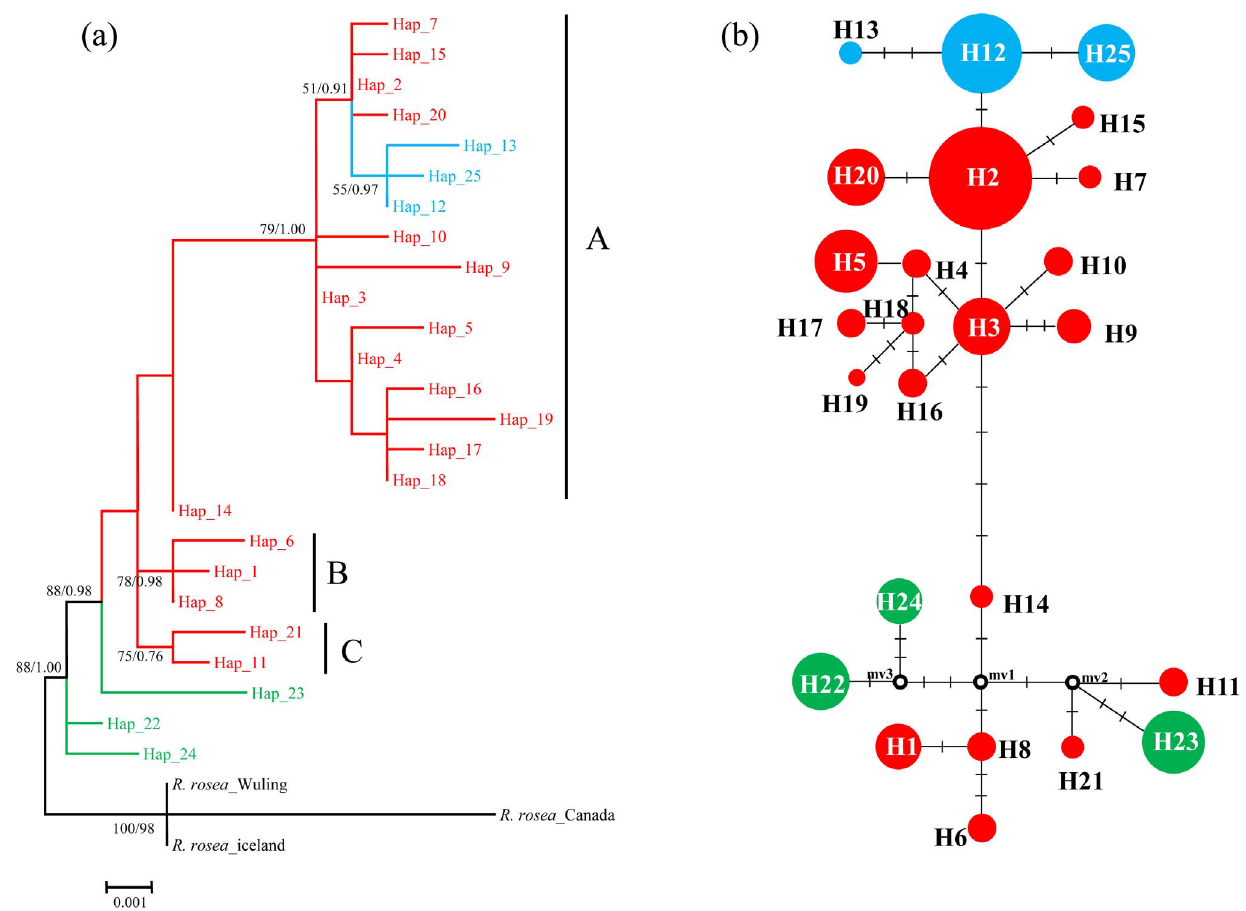
Figure 2. Phylogenetic relationships obtained by analysis of pDNA haplotypes. (a) Bayesian tree with numbers above the branches indicating bootstrap values greater than 50% for MP analysis and Bayesian posterior probabilities. (b) NETWORK-derived genealogical relationship. The sizes of the circles in the network are proportional to the observed frequencies of the haplotypes. The small black bars represent mutation steps and the red dots represent missing chlorotypes. For both subfigures, different colors represent different geographic origins of haplotypes: red, the Qinghai-Tibetan Plateau and Hengduan Mountains; blue, northern China; green, central Asia.